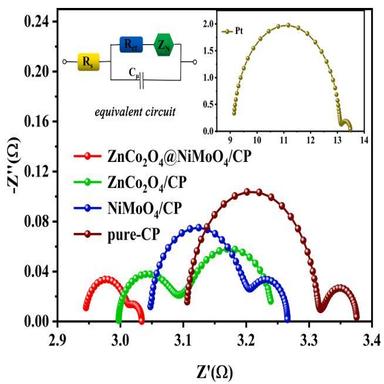
EIS curves of virtual battery based on different materials.